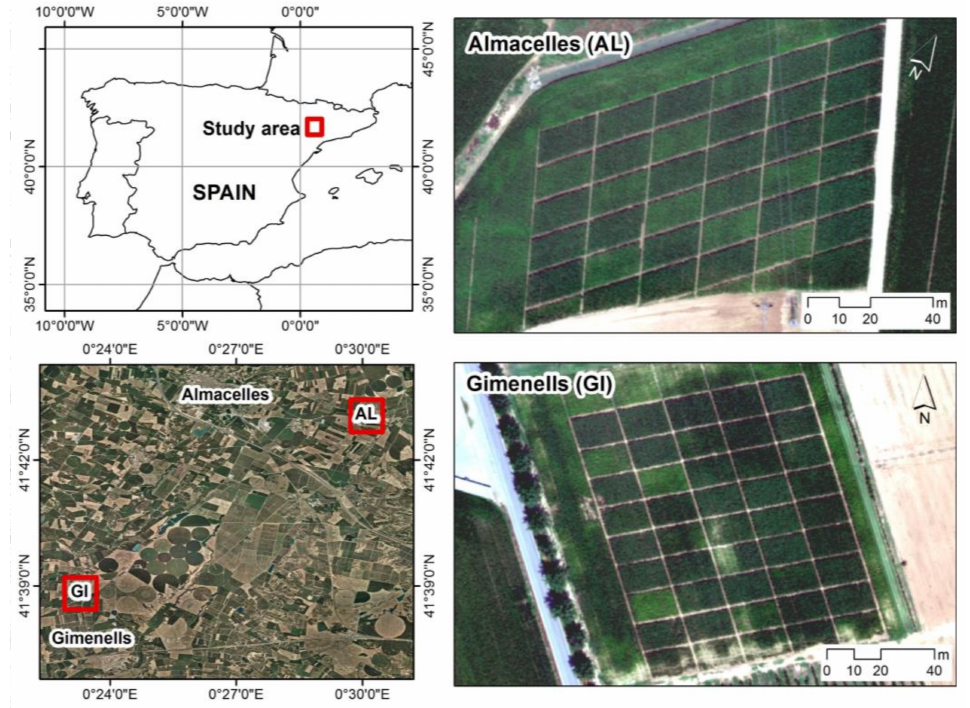
Figure 1. Location of the study area and detail of the experimental fields: Almacelles (AL) and Gimenells